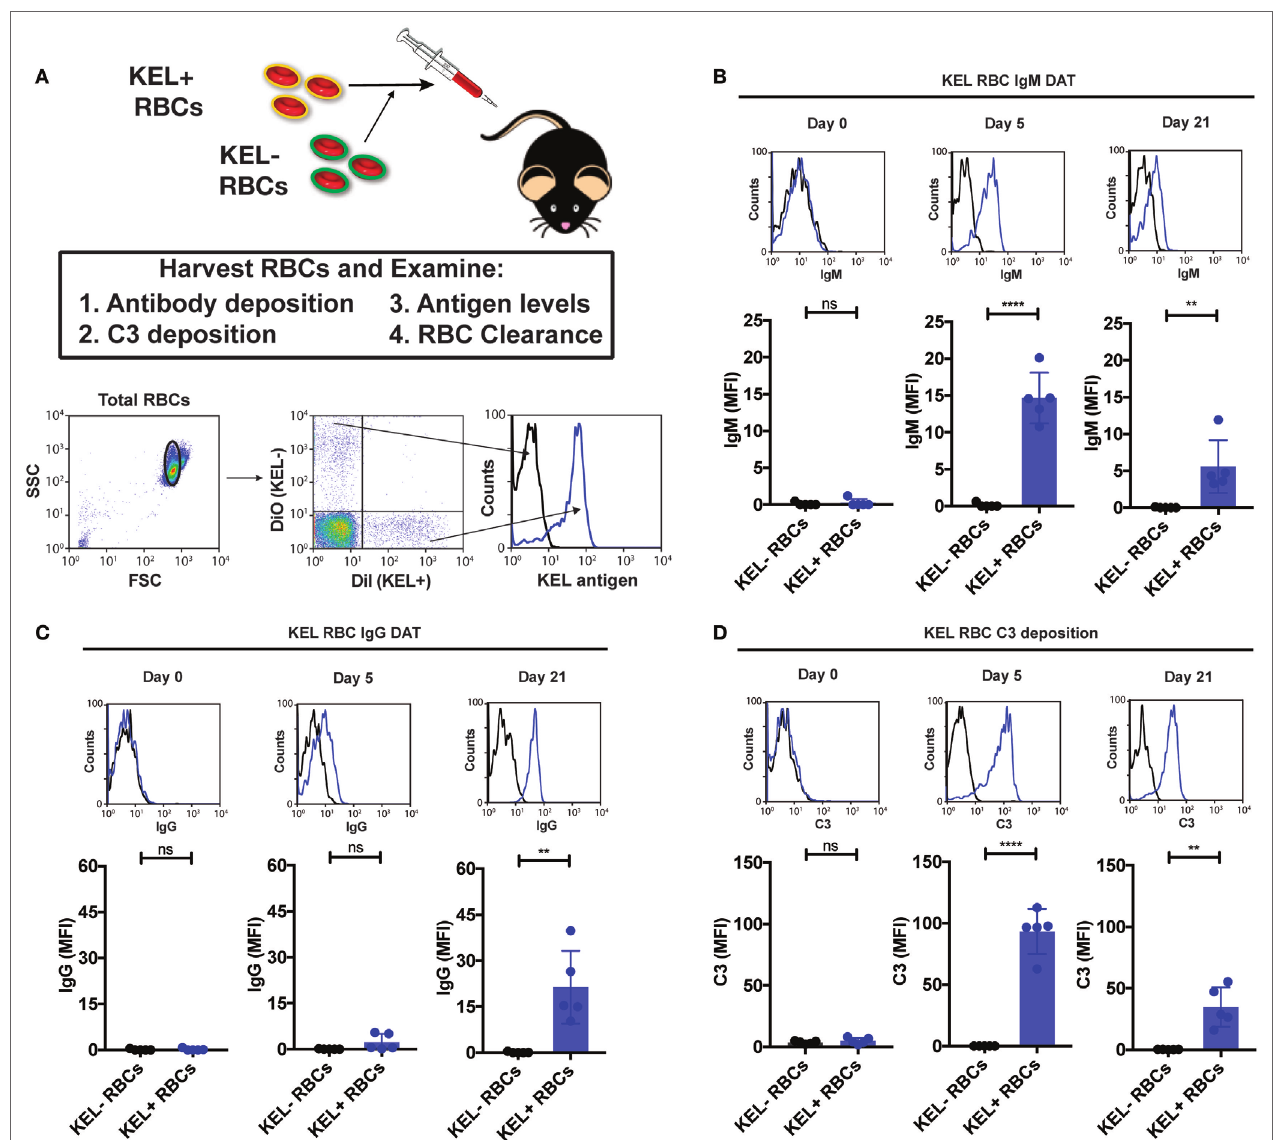
FigUre 1 | IgM, IgG, and complement component 3 (C3) specifically deposit on KEL positive red blood cells (RBCs) post-transfusion. (a) Schematic overview of approach used to detect IgM, IgG, and C3 on the surface of RBCs post-transfusion. Packed DiI-labeled KEL RBCs were co-transfused with packed